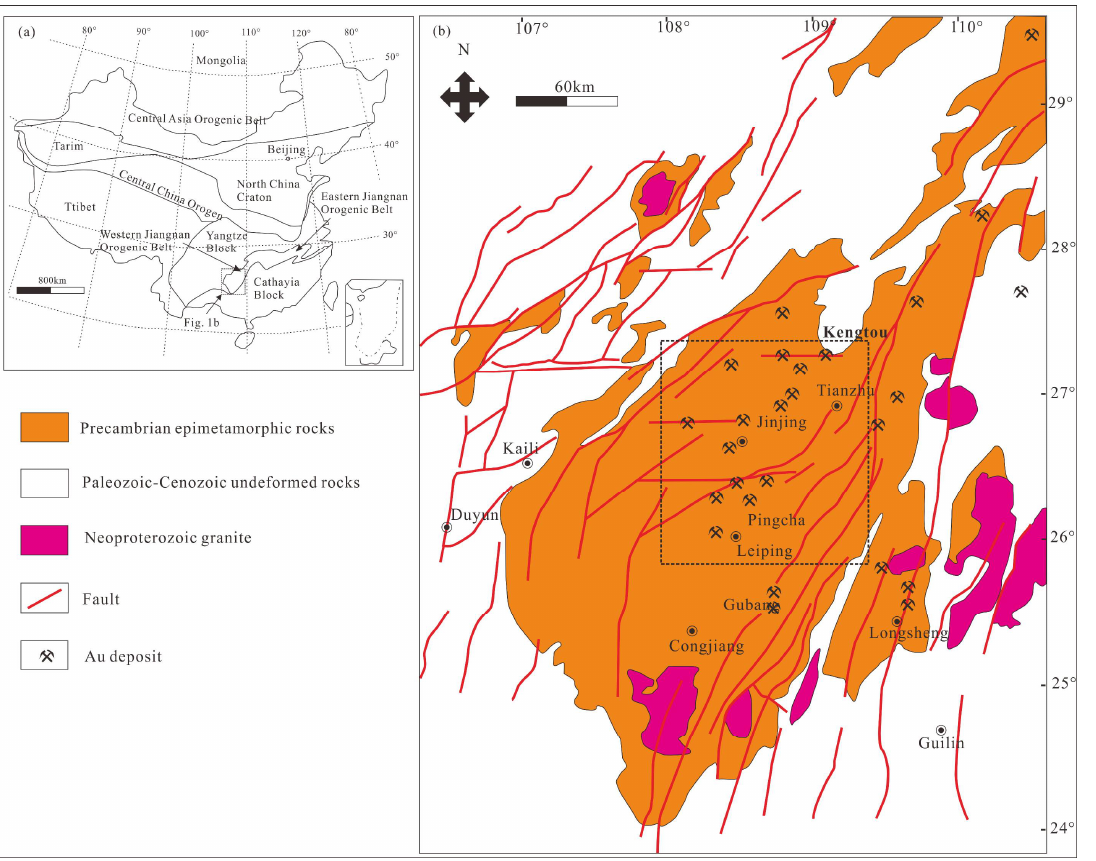
Figure 1 Figure 1. ( a ) Geological sketch map of China (modified from [8,16]); ( b ) Geological map of the western part of Jiangnan Orogenic Belt, showing the location of Precambrian rocks, granitic intrusions and gold deposits (modified from